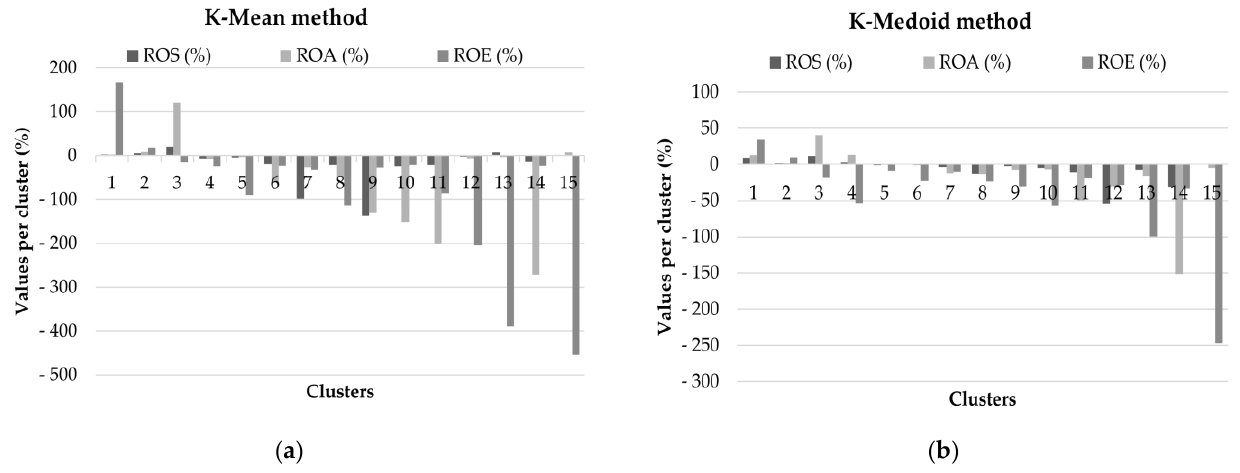
Figure 8. Average financial indicator values per cluster for Romanian companies: ( a ) K-Mean method; ( b ) K-Medoid method. Source: Authors’ own editing based on own calculations.